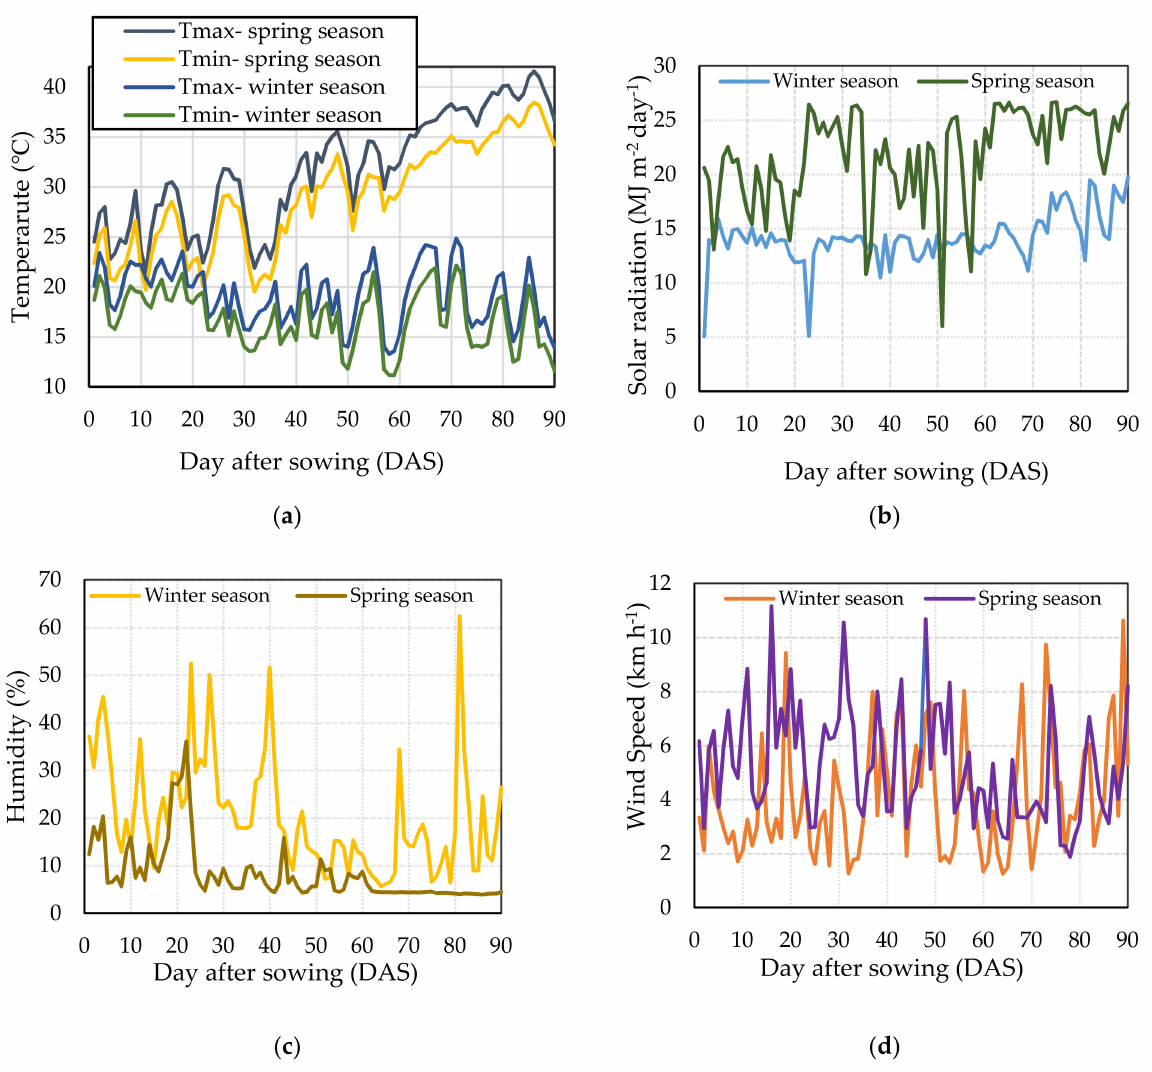
Figure 1. Daily climate parameters in the winter and spring of 2018–2019 during the squash growing seasons: ( a ) Daily maximum and minimum temperature, ( b ) solar radiation, ( c ) relative humidity, and ( d ) wind